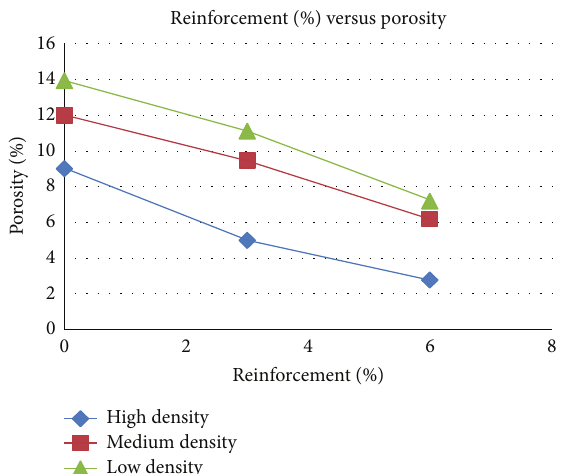
Figure 4: Variation of porosity of Al-Gr composites with varying graphite contents.